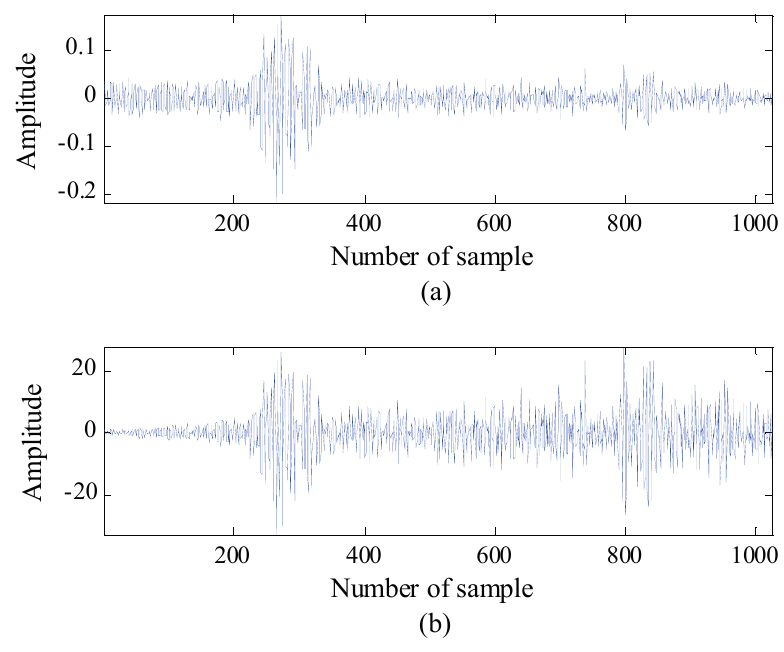
Figure 3. Compensation for a weak signal (two targets are moving in this example): ( a ) the signal observed before compensation and ( b ) the signal observed after